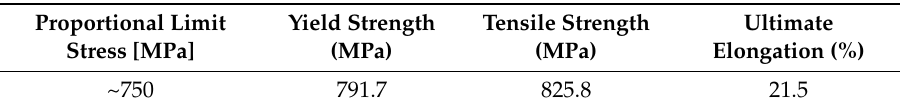
Table 2. Main steel properties.